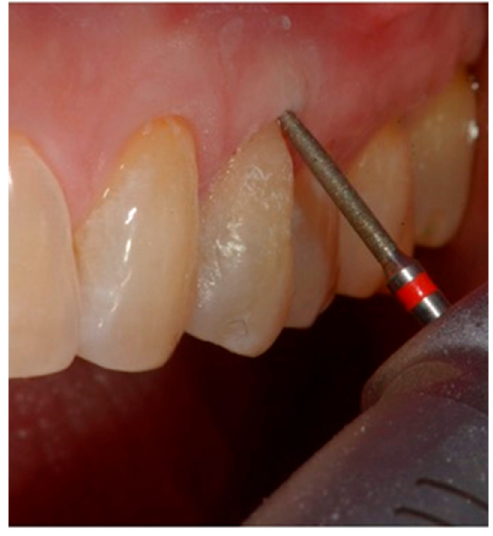
Figure 8. Finishing of the restoration with a flame bur with a 45° angle.